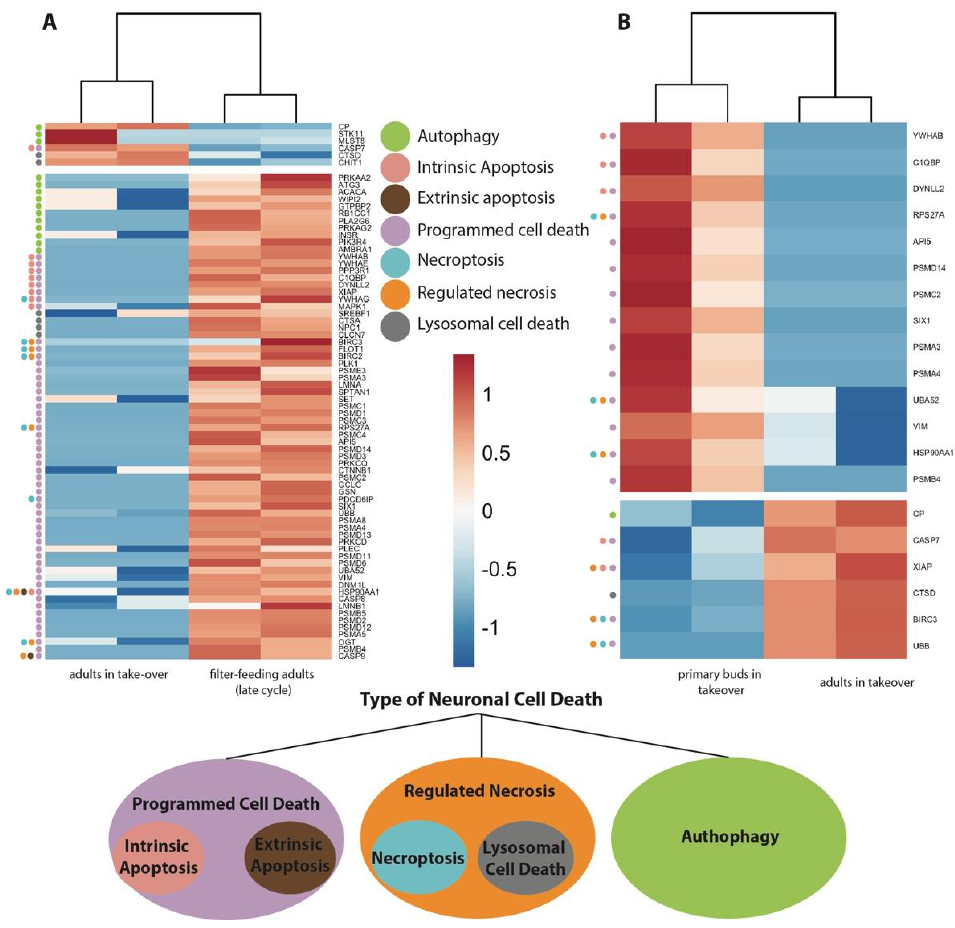
Figure 6. Putative homologous genes associated with neuronal cell death are differentially expressed in zooids during the weekly cycle when comparing filter-feeding adults (late-cycle) and adults in takeover ( A ) and comparing adults in takeover with primary buds in takeover ( B ). Colored dots on the heatmap left indicate the cell death forms in which the genes are involved. Color scale in A and B depicts log2CPM normalized expression values scaled by row.